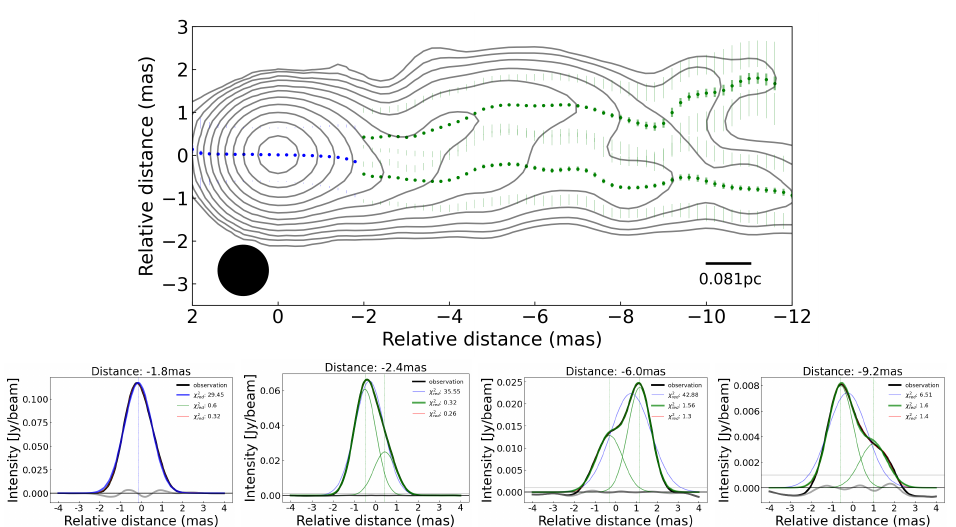
Figure 1. ( Top ) Example of the Gaussian model fitting results for drawing the ridge line of one epoch at the KaVA 22GHz (25 February 2016). The image has been rotated by − 18 degrees. Contours start at 3 σ rms , increasing in steps of 2. The black circle in the bottom left corner represents the size of the restoring beam, namely 1.2mas circular Gaussian. ( Bottom ) Transverse brightness distributions at 4 different locations (at distances 1.8, 2.4, 6.0, 9.2 mas) and their Gaussian model fit results. The blue and green dots are the peak and FWHM positions of the best-fit results of single or double Gaussian models,